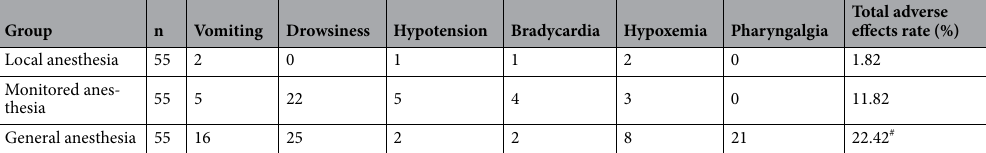
Table 4. Adverse effects during anesthesia (n). # Statistical difference among three groups (P < 0.05).